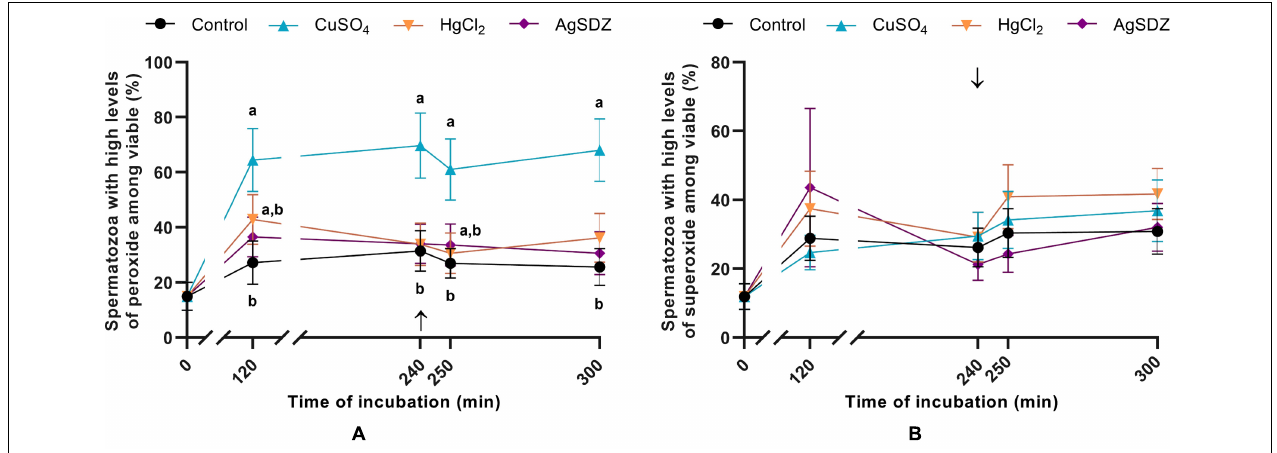
FIGURE 5 | Intracellular levels of ROS. (A) Percentages of spermatozoa with high intracellular levels of hydrogen peroxide within the viable sperm population (%) and (B) percentages of spermatozoa with high intracellular levels of superoxide within the viable sperm population (%) in samples exposed to the presence or absence of different AQP inhibitors in the capacitation medium: cooper sulfate (CuSO 4 ), mercury chloride (HgCl 2 ) and silver sulfadiazine (AgSDZ). Data were collected after 0, 120 and 240 min of incubation in capacitation medium. At this point, progesterone was added to capacitation medium (arrow) and data were collected after further 10 min and 60 min of incubation. Data are shown as mean ± SEM, and different letters (a,b) indicate significant differences ( P < 0.05) between different treatments within a given time point.